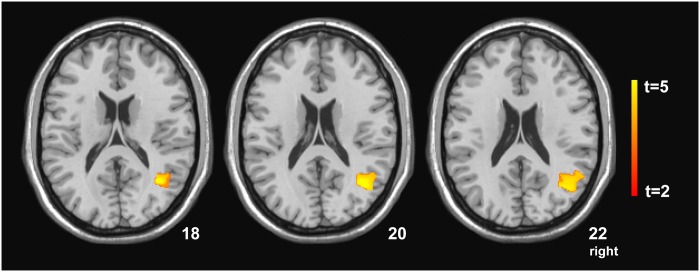
Statistical parametric mapping (t) intensity projection maps rendered onto a stereotactically normalized MRI scan, showing a voxel cluster of the significant interaction of increases of both grey matter volume and training effects in response accuracy for the younger group vs. the older group (statistical significance is thresholded at p < .001, FWE p < .05 corrected at the cluster level).The number at the bottom right corner of each MRI scan corresponds to the z coordinate in MNI space. The right side of the image corresponds to the right side of the brain.